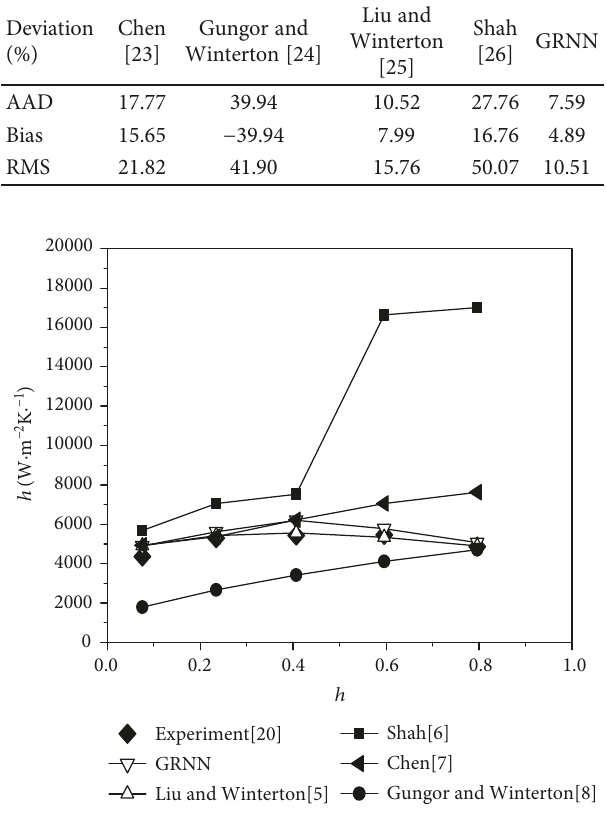
Figure 5: When the evaporation temperature is 40 ° C, the heat transfer coe ffi cient of R245fa changes with dryness and mass fl ux rate.